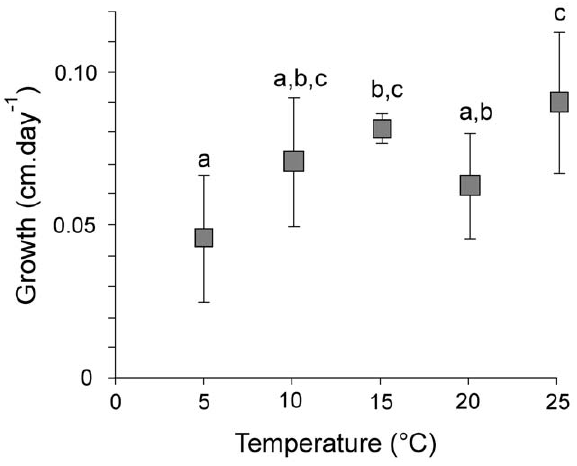
Figure 3. Growth rates of Sphagnum at different temperatures. Growth rates are measured after two months of incubation. Values are expressed in cm and represent means of four replicates 6 s.d. Letters indicate statistically significant groups of data ( P ,